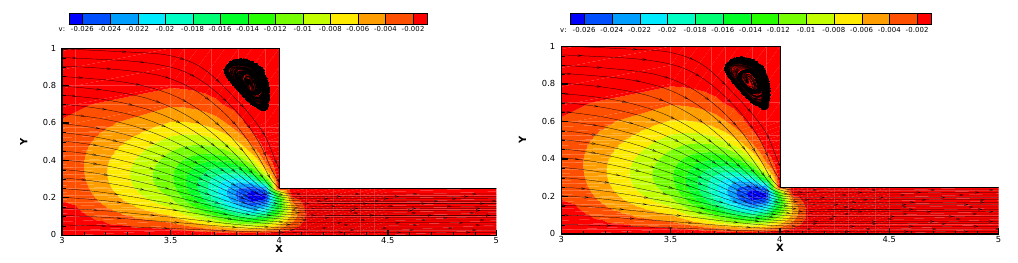
Figure 3. Streamlines and magnitude of velocity contours u for one-level method: steady state viscoelastic fluid flow ( left ), Oseen viscoelastic fluid model ( right ).